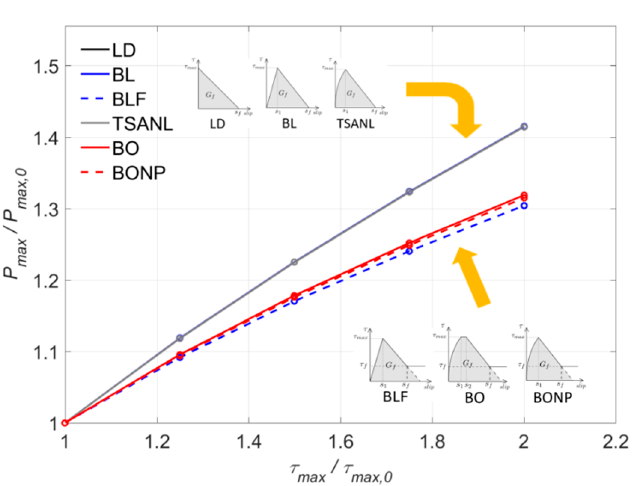
Figure 15. Variation of P max versus τ max .